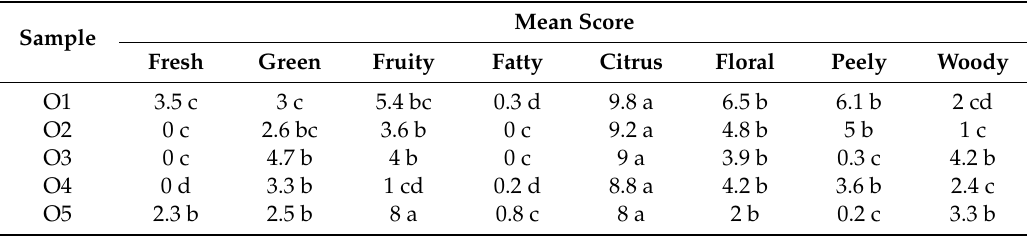
Table 4. The mean intensity values of the eight attributes for the five sweet oranges in descriptive sensory evaluation.